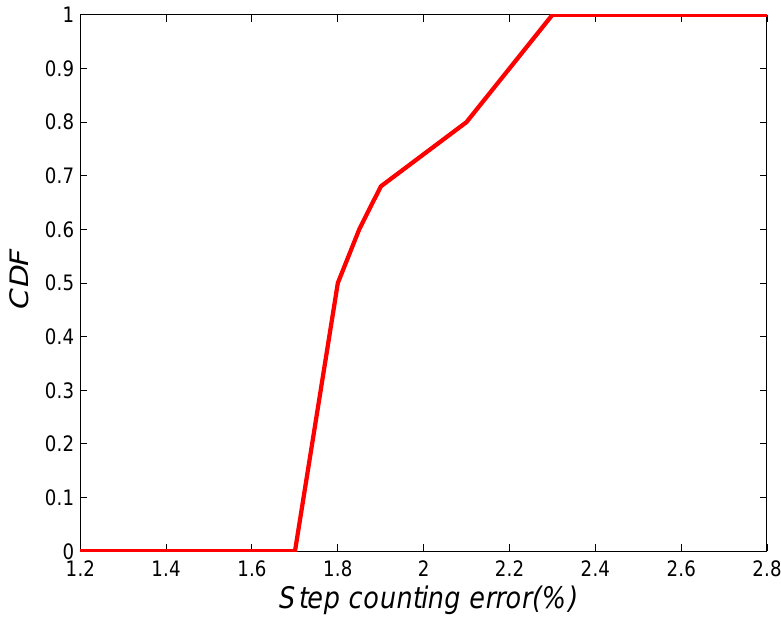
Figure 9. CDF of step